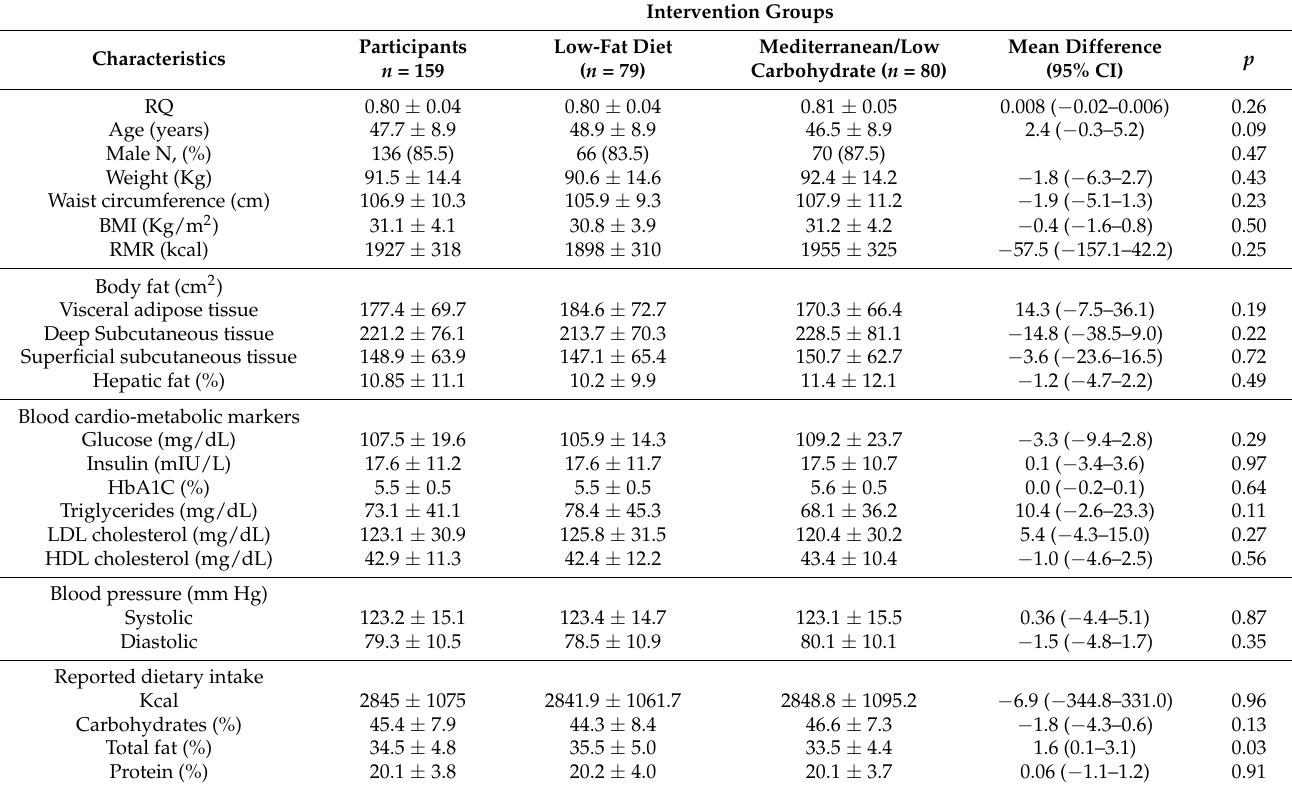
Table 1. Baseline characteristics of the study participants with full metabolic assessment across diet intervention groups. Intervention